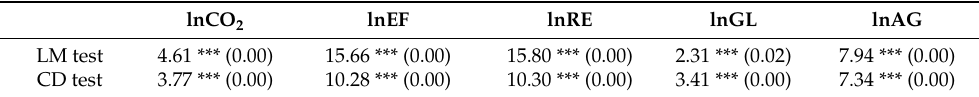
Table 5. CD test.